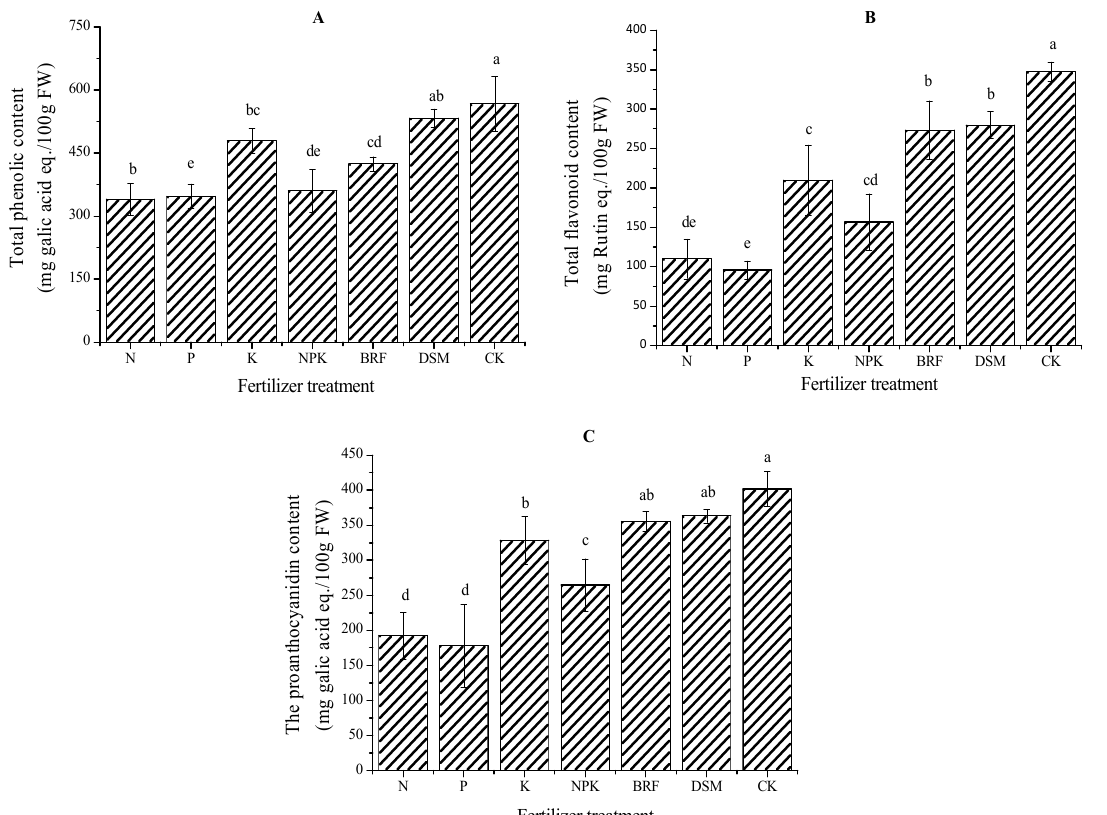
Figure 1. Changes of total phenol, flavonoid and proanthocyanidin content of jujube produced with different fertilizer